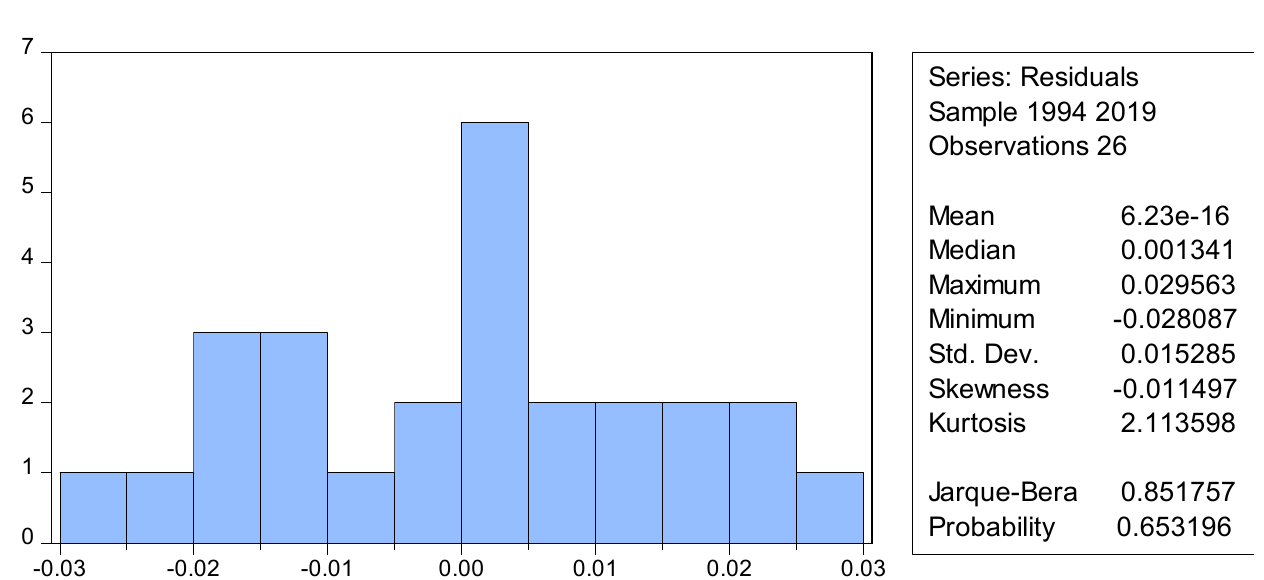
Figure A1. Normality test result. Table A2. Serial correlation test result.